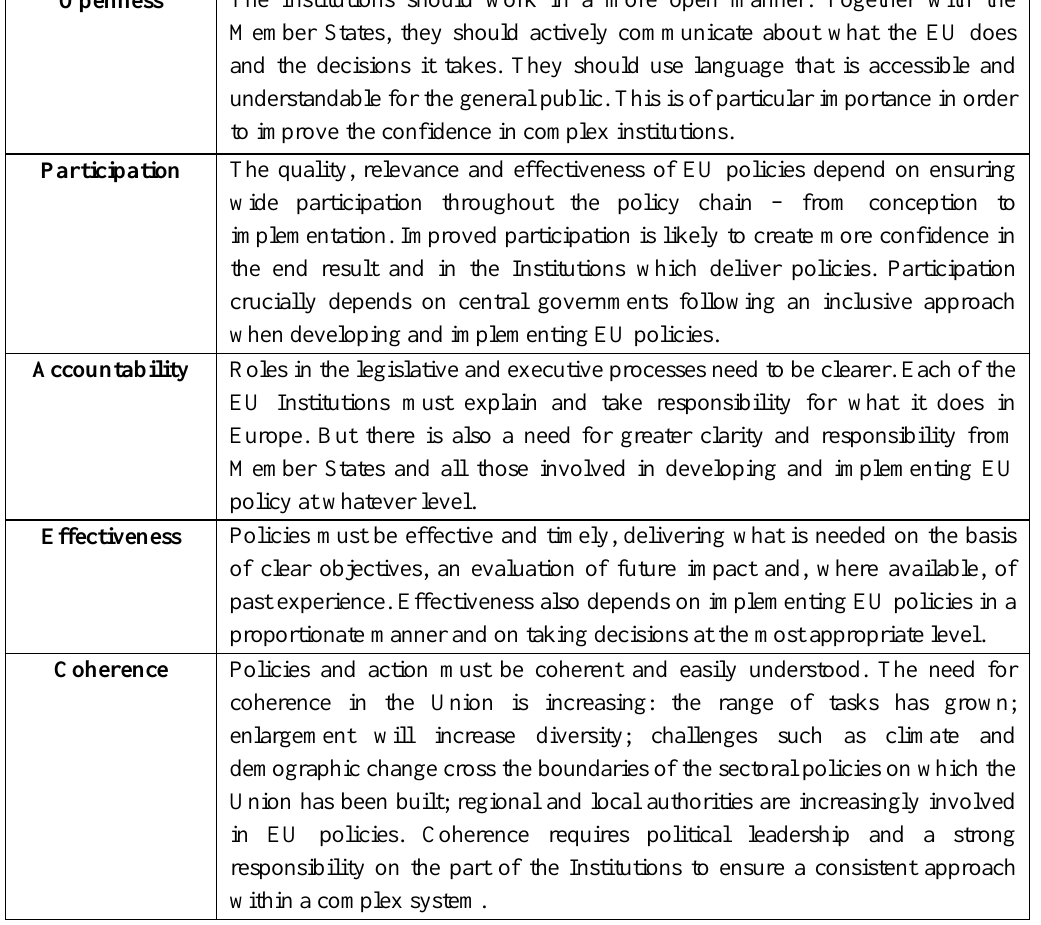
Table 2: Principles of Good Governance